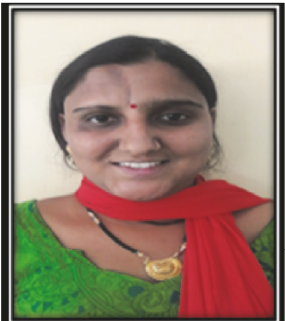
Figure 5: At 12-month recall, patient reports complete absence of dystonic movements with improved quality of life assessment with a maintenance dose of carbamazepine of half tablet at night time only. Patient reports to have been leading her normal life and was visibly happy during the checkup visit. However a marked bulge is still apparent on her right half of forehead region which could be due to the muscular hyperactivity with probable hypertrophy in the involved muscle, a feature which has not been reported in the previous reported